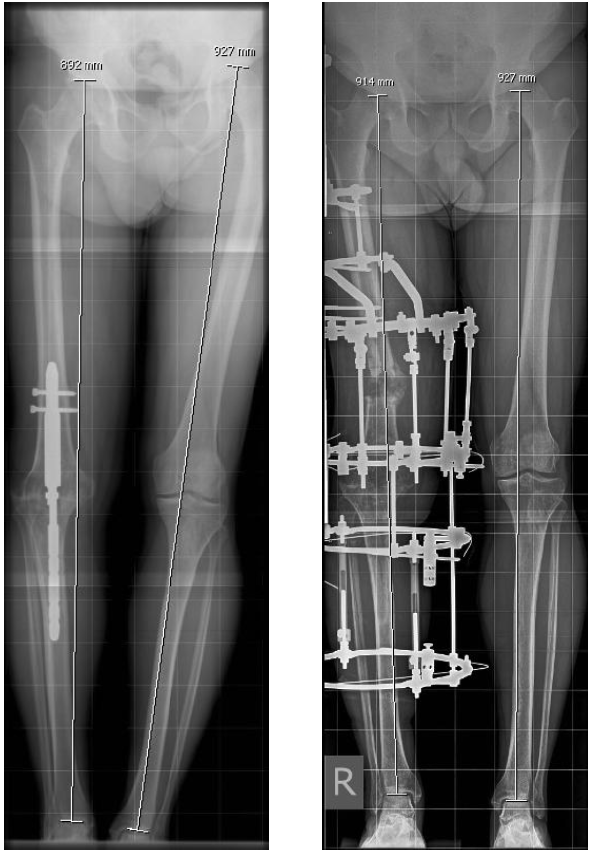
Figure 2 : a) RX full leg with WFN in situ. b) RX full leg after extraction of WFN and correction length and